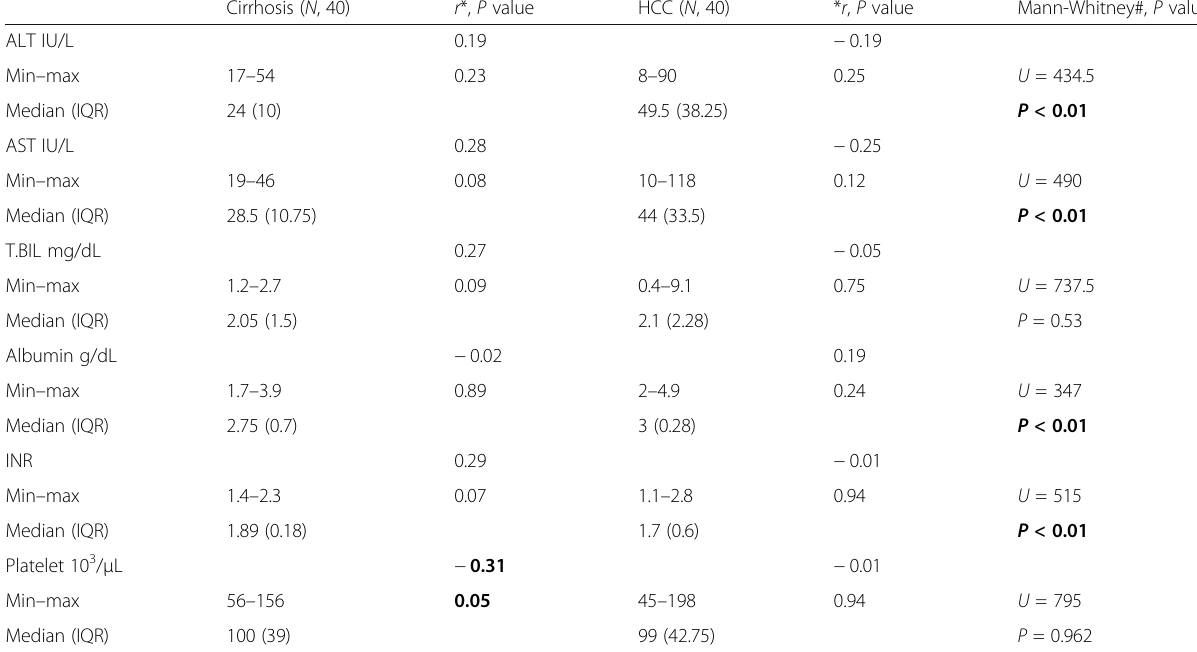
Table 2 Lab results in the study sample and relationship with α 2 δ 1 Cirrhosis ( N , 40) r *, P value HCC ( N , 40) * r , P value Mann-Whitney#, P value 0.19